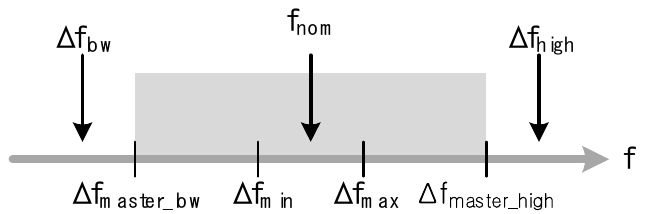
Figure 5. Relationship between frequency settings.